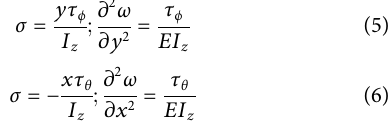
where σ is the bending load, I z is the inertia, τ ϕ and τ θ are the roll and pitch torques ( ϕ and θ are the roll and pitch angles), E is Young ’ s modulus, and ω is the maximum bending displacement. The comparison between analytical results (deformations measurements in this case are complex to obtain experimentally) is shown in Tables 1 and the proposed models for roll (7) and pitch (8) adjust with great precision to them (with the constants A = 8.76, B = − 1.2, C = 0.08, D = 2.92, and E = 0.91 for roll and A = 4.38, B = − 0.78, C = 0.06, D = 2.34, and E = − 0.43 for pitch).